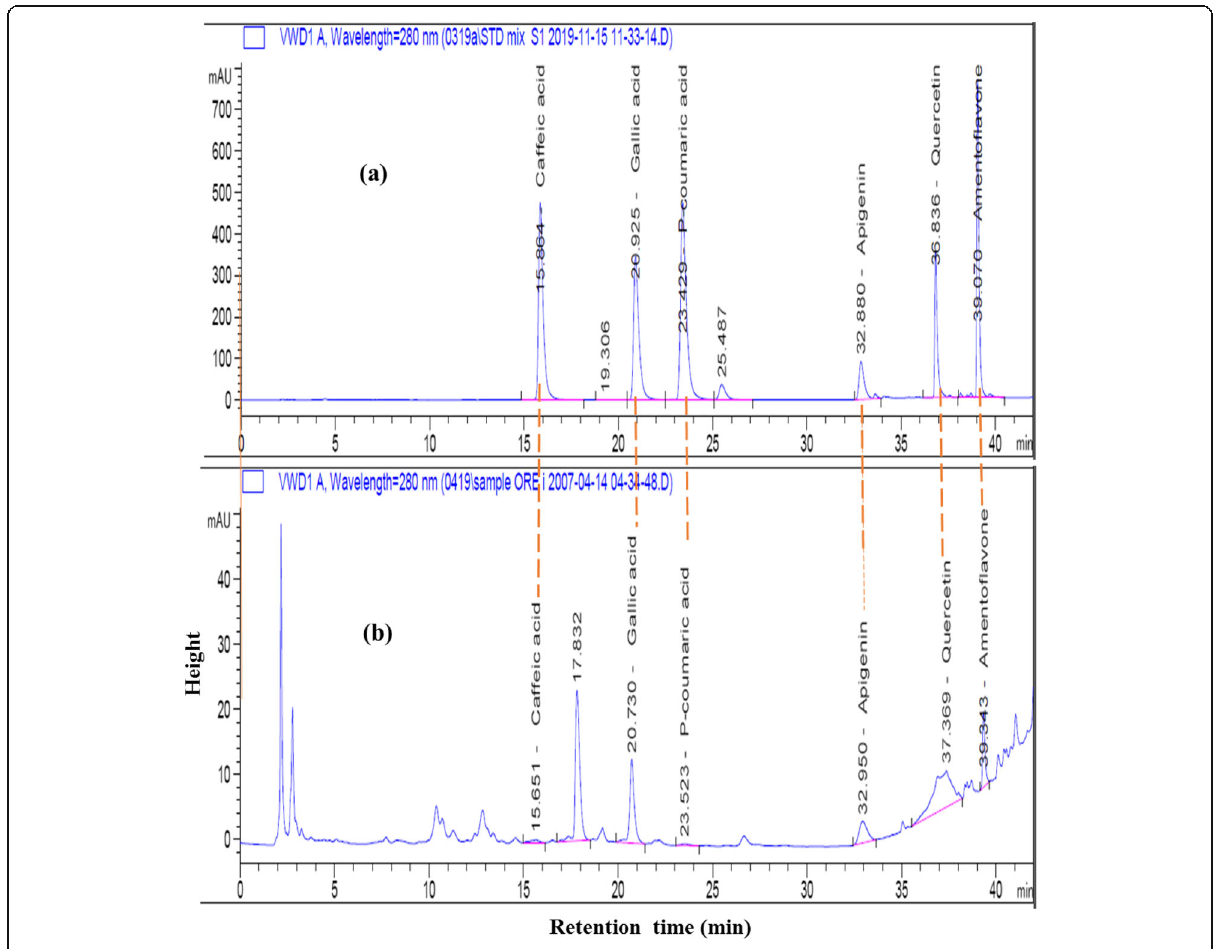
Fig. 3 Chromatogram of flavonoid standards a and crude ethanol extract of Nigella sativa b